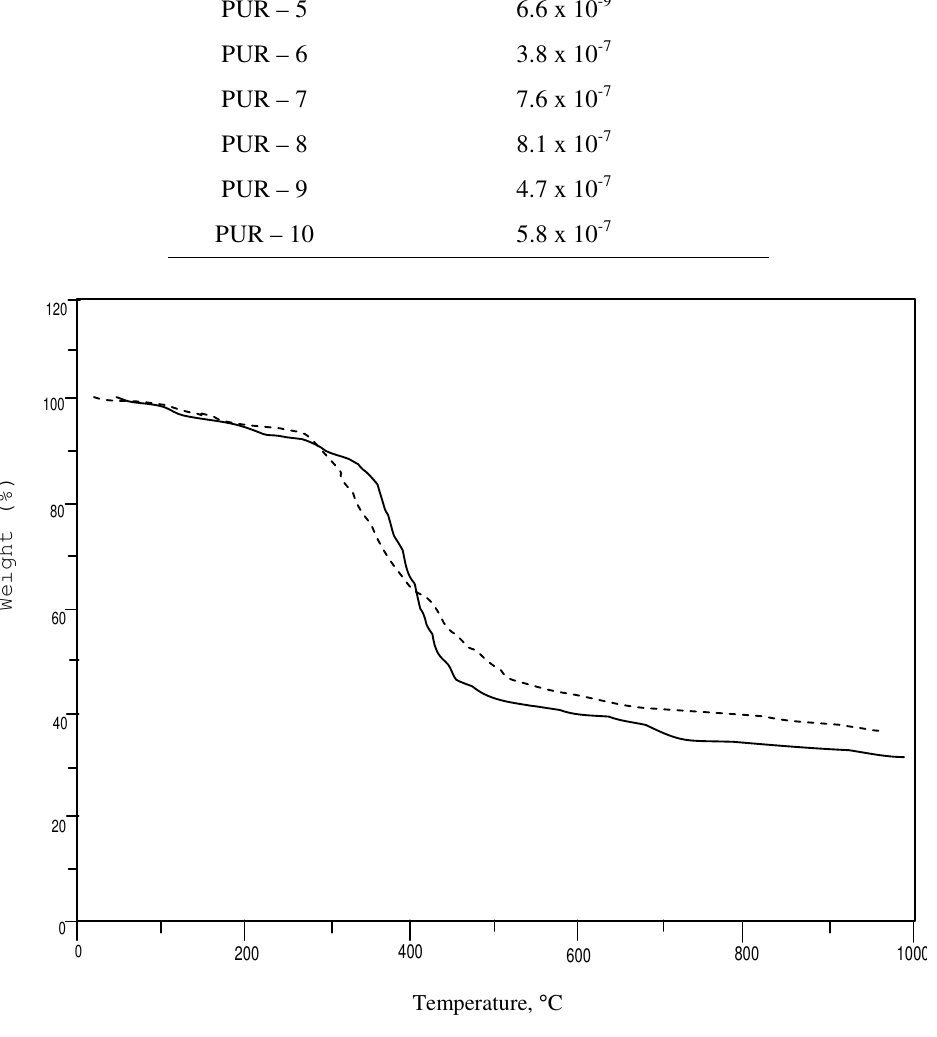
Figure 1. TG thermogram of polyureas